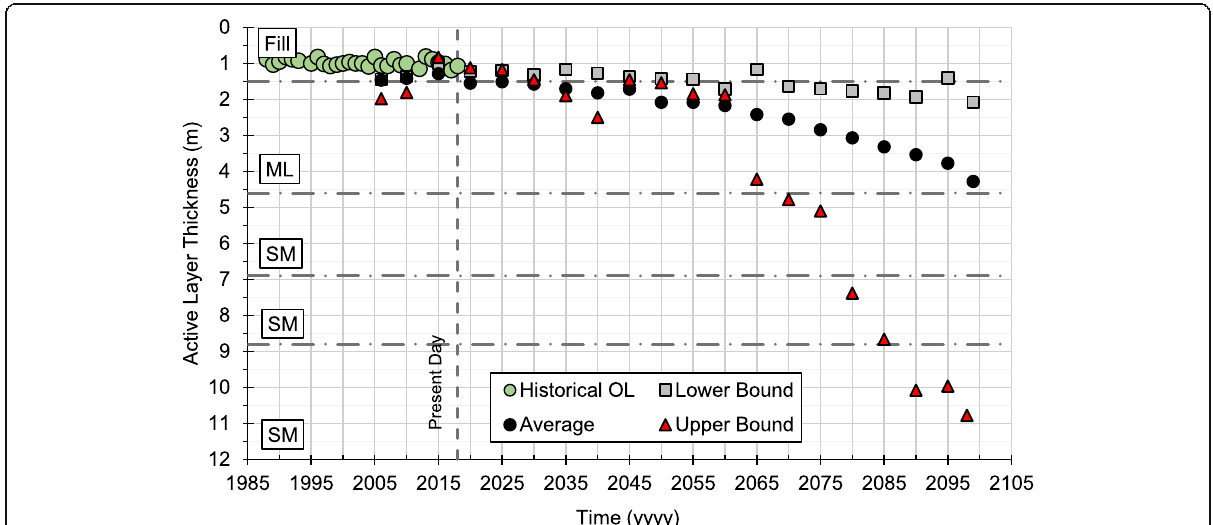
Fig. 11 Modeled ALT when a gravel pad is emplaced at the site, with development occurring in 2006. The modeled historical organic layer ALT is provided for reference. Scenarios 1, 2, and 3 are represented by Average, Upper Bound, and Lower Bound in the figure,